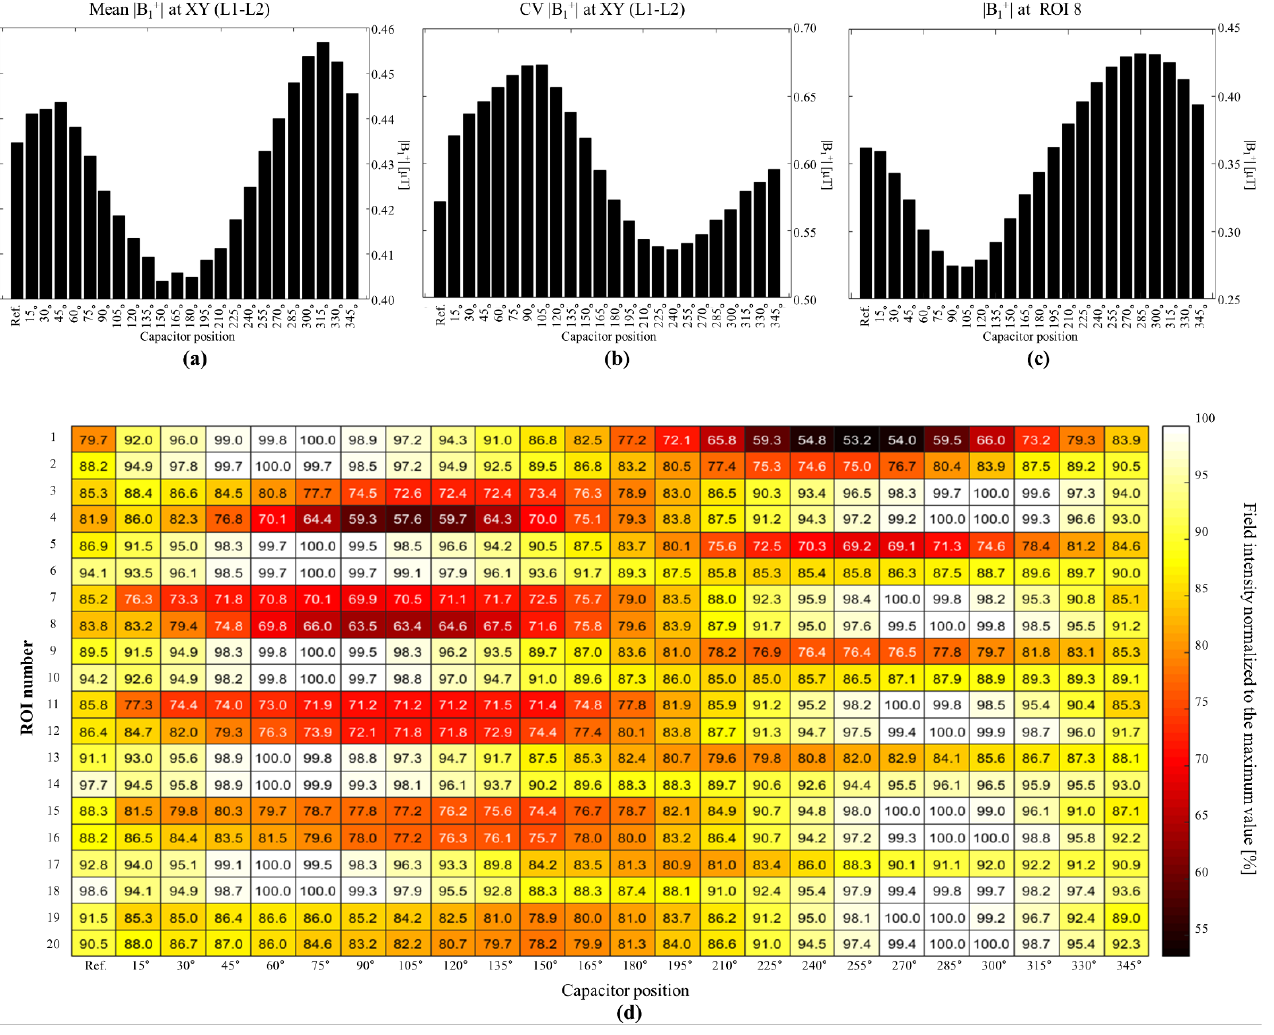
Figure 8. ( a ) Mean values of |B 1+ | field in the XY plane, ( b ) CVs in the XY plane, ( c ) mean values of |B 1+ | field in ROI 8 for all tested coil configurations. ( d ) Mean values in all ROIs of phantom for all tested coil configurations.